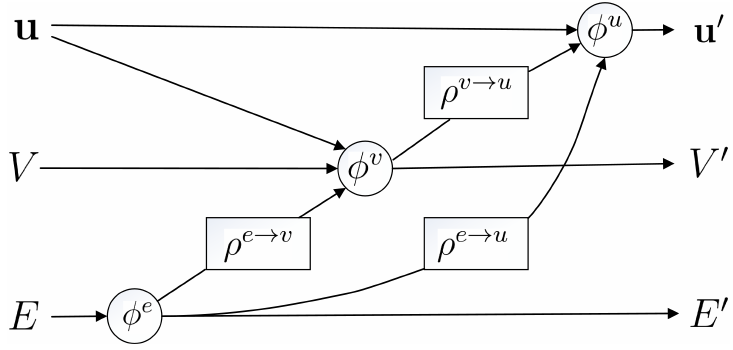
Figure 3. Computation flow chart of graph network block.